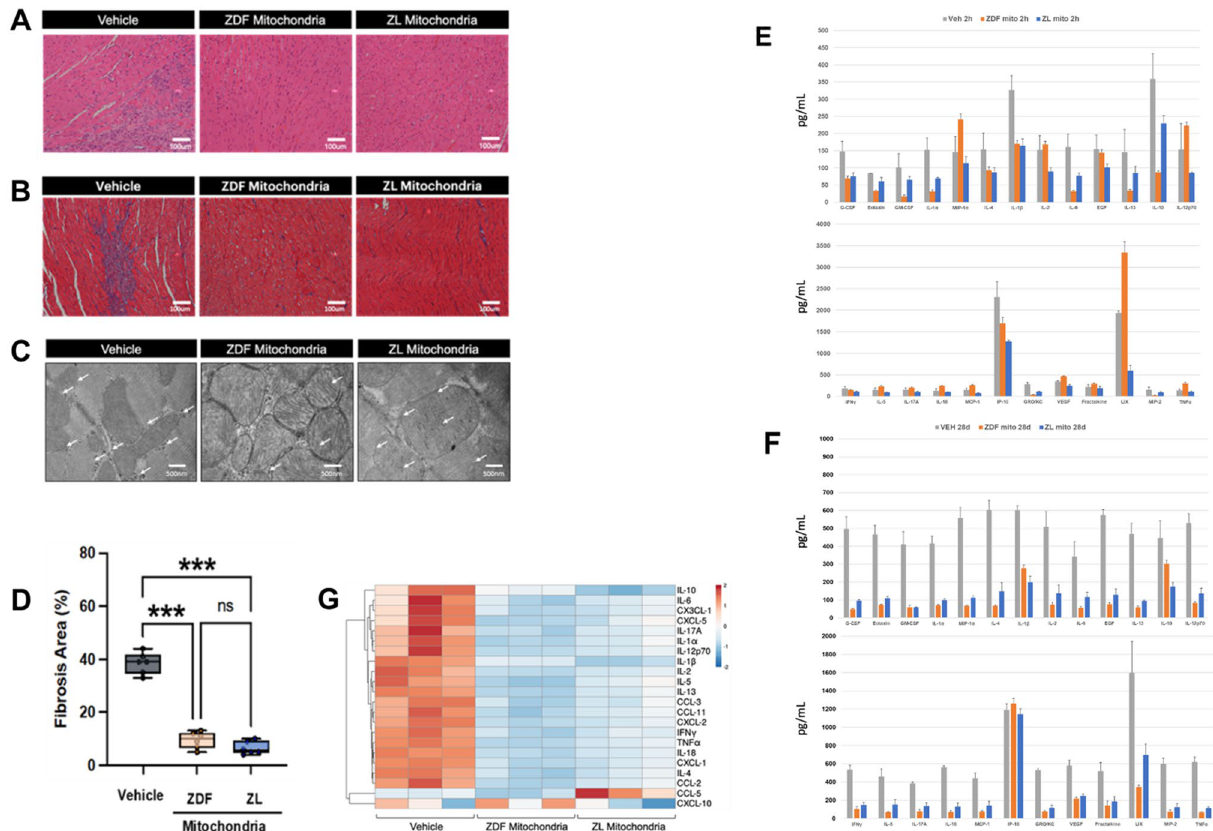
Figure 5. Histology and multiplex analysis. Micrographs of ZDF rat hearts following 30 min. regional ischemia and 2 h (Hematoxylin and Eosin stained) ( A ) and 28 days (Masson’s tri-chrome stained) ( B ) recovery. Hearts receiving vehicle alone (Vehicle) show increased longitudinal and transverse interfibrillar separation as compared to hearts receiving diabetic ZDF -mitochondria and non-diabetic ZL -mitochondria. Representative transmission electron microscopy images ( C ) of ZDF rat hearts 28 days following 30 min of regional myocardial ischemia. Vehicle heart have swollen and electron-translucent mitochondria, with an enlarged intermembrane space, a disrupted matrix and calcium accumulation. Hearts that received either diabetic ZDF- or non-diabetic ZL-mitochondria show only traces of calcium accumulation in mitochondria and preserved mitochondrial structure. White arrows indicate calcium deposits. Magnification 16,000 x. All results are shown as the mean plus and minus the standard error of the mean for n = 6 for each group. Statistical differences are shown. Fibrosis area ( D ) calculated as the percentage of fibrotic tissue area (stained in blue) over the whole area of the myocardium per Masson’s trichrome slide. as * p < 0.05, ** p < 0.01, *** p < 0.001; ns: not significant. Multiplex (42- plex) analysis of cytokines and chemokines using the Human Cytokine 42-plex Discovery Assay was performed for hearts following 30 min regional ischemia and 2 h ( E ) and 28 days ( F ) recovery for hearts receiving vehicle alone (Vehicle) or diabetic ZDF- or non-diabetic ZL -mitochondrial transplantation. Significantly increased cytokines as compared to vehicle. ** p < 0.001. G : Heatmap showing peripheral blood cytokine analysis at 28 days recovery. The log fold change is shown with pseudocolor scale (−2 to 2) with blue denoting down-regulation and orange denoting up-regulation. Samples run in Comparison of transcripts identified in hearts receiving non-diabetic ZL- as compared to those receiving diabetic ZDF-mitochondrial transplantation at 28 days recovery revealed three differentially upregulated path- ways in hearts receiving nondiabetic ZL-mitochondrial transplantation. These upregulated pathways were for muscle contraction and skeletal muscle development and calcium transport (Fig. 7B,C). When overlapping the top 25 upregulated pathways implicated in the transcriptomic differences between hearts receiving diabetic ZDF and hearts receiving non-diabetic ZL- mitochondrial transplantation at 2 h and 28 days recovery, muscle contraction, skeletal muscle development cell adhesion, cytoskeleton organization and anti-apoptosis were shown to be commonly enriched pathways (Fig. 8A).